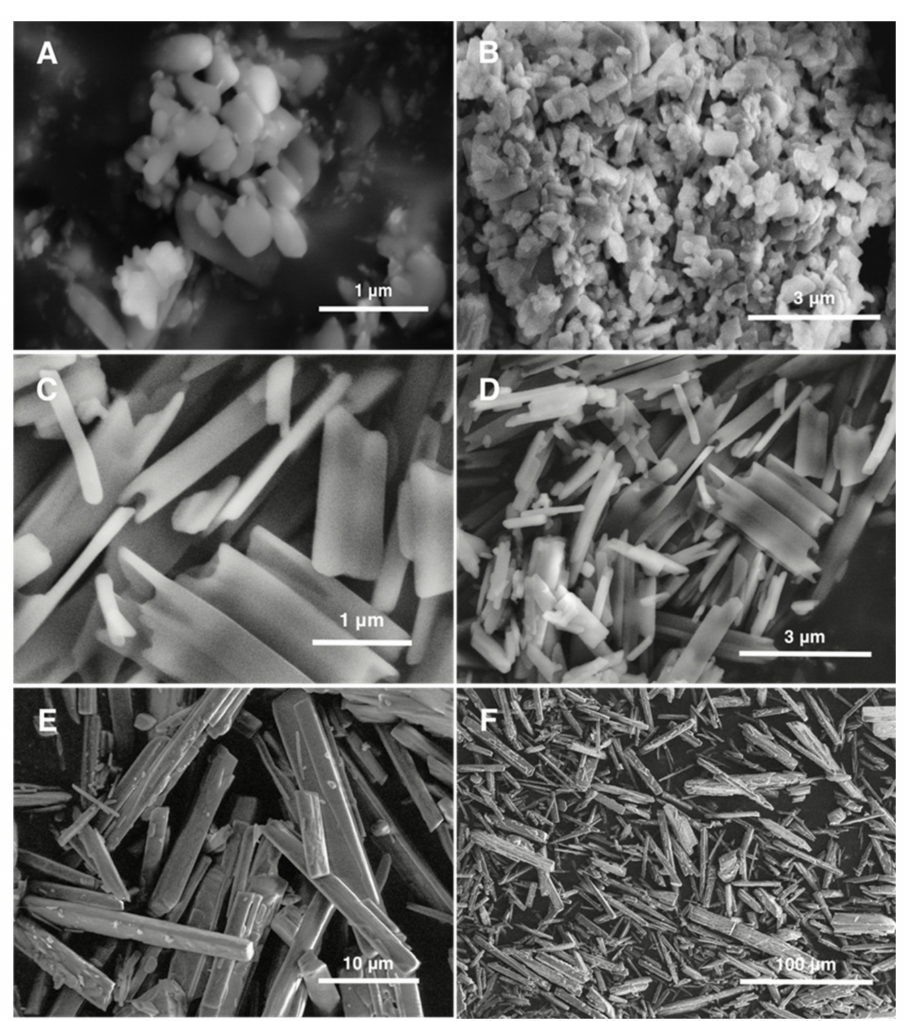
Figure 2. SEM images of NanoA ( A , B ), NanoB ( C , D ), and CCG-211790 bulk powder ( E , F